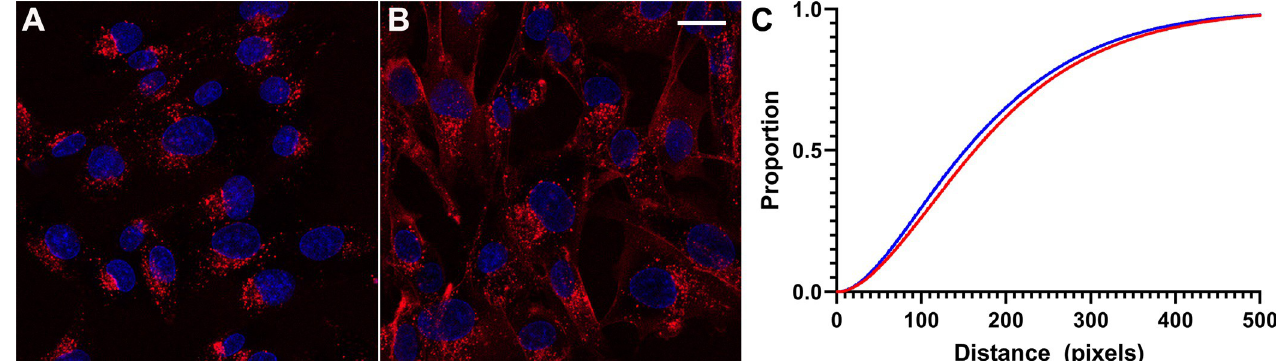
Fig 7. Distance analysis. A, TAT-MBP only and B, TAT-NMRCaM/CBS-MBP) complexes are representative images. C, distribution of (Blue) TAT-MBP and (Red) TAT-NMRCaM + CBS-MBP pairwise distances of fluorescent pixels are compared using the Kolmogorov-Smirnov Test for significance. Analysis completed using SAS 1 Studio software. Data set 10% of original size and values of “0” removed. X-axis = distance values where adjacent pixels have a distance value of 1. Y-axis = proportion of values, e.g. proportion of 0.4 = 40th percentile of data set.